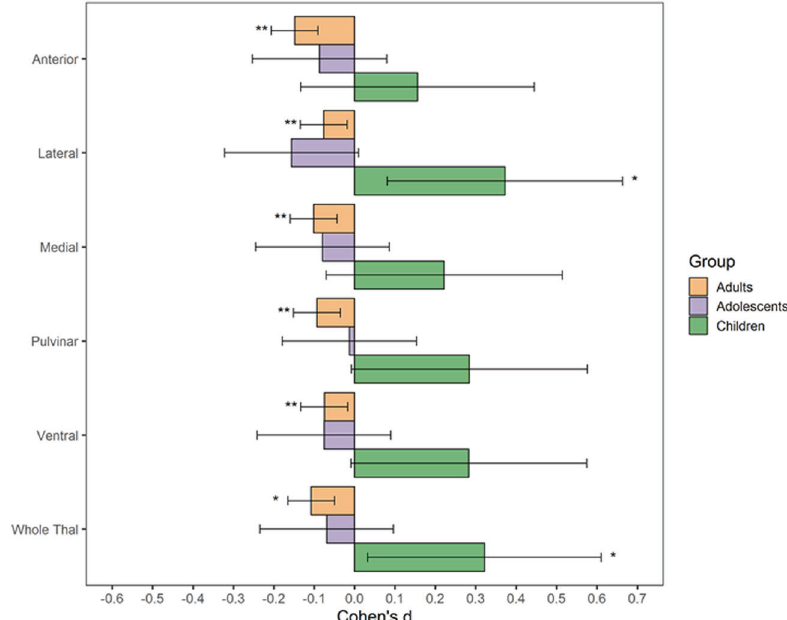
Fig. 2 Volumetric differences between obsessive-compulsive patients and healthy controls by age group. * p uncorrected < 0.05; ** p FDR < 0.05; volumetric differences are adjusted for age, sex and intracranial volume. Thal